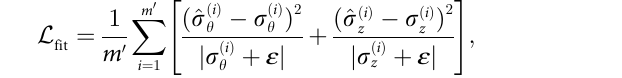
S1 Fig. Biomechanical data of aorta samples from mice with all four genotypes. Data were obtained through biaxial tests using a seven-step protocol, including three inflation cycles